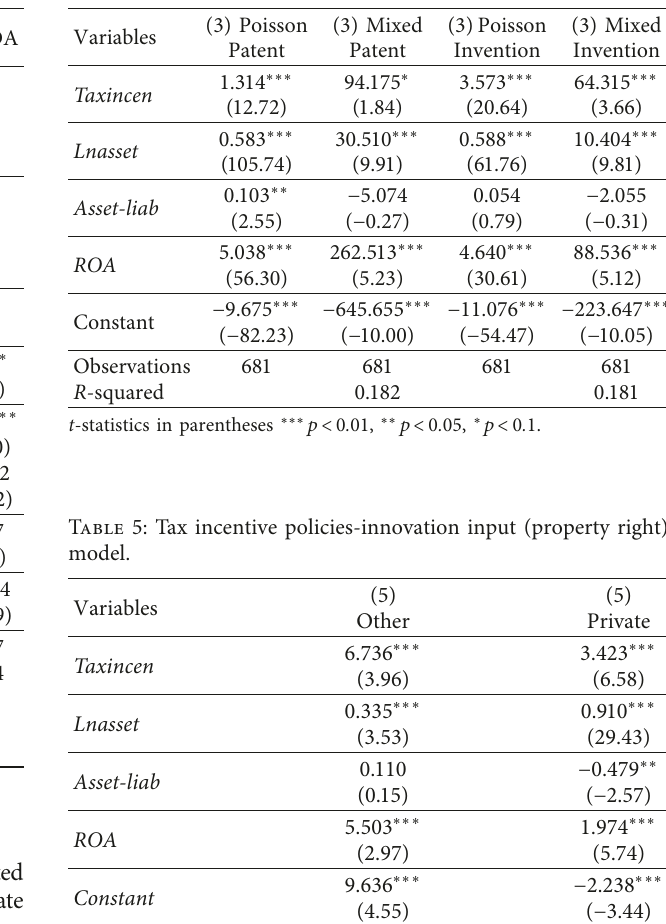
Table 2: Correlation analysis of main variables.